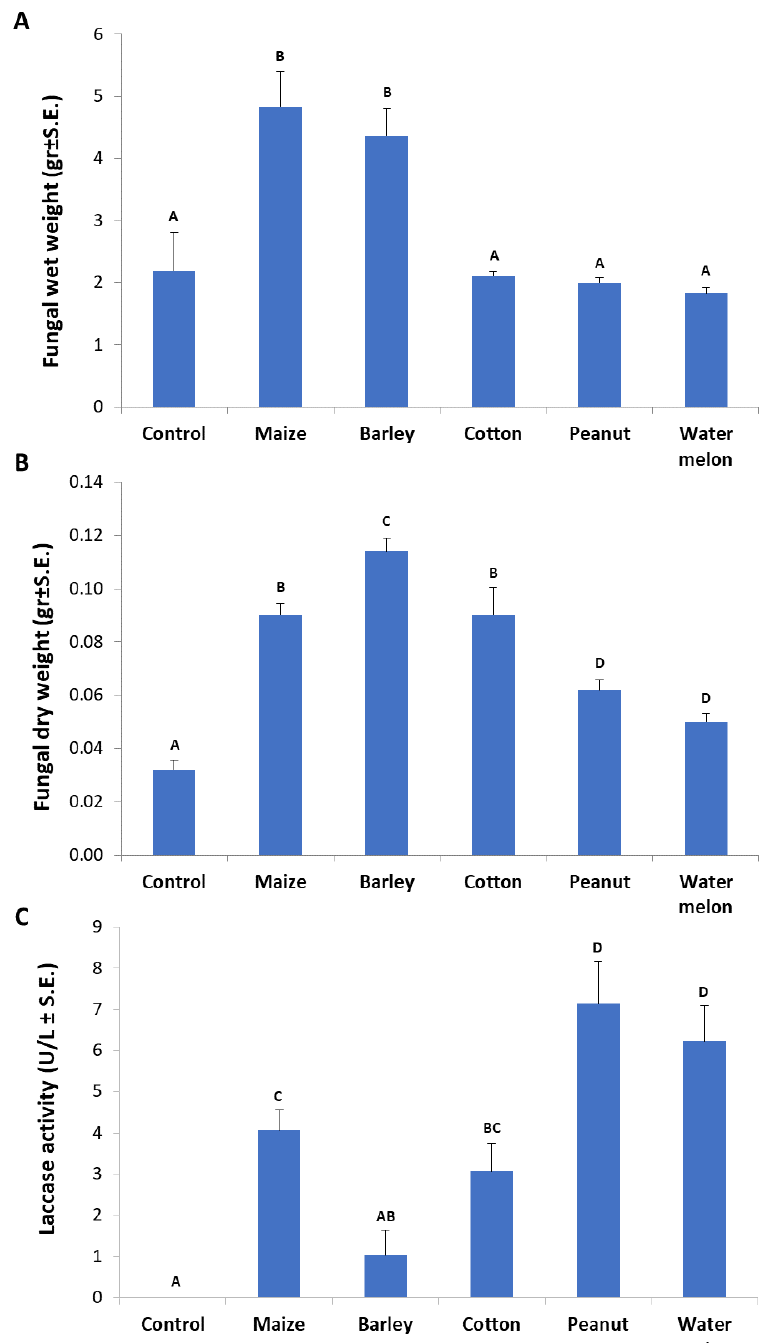
Figure 6. Influence of various plant species root powder on M. maydis growth in liquid minimal medium: The fungus was grown for seven days in 50 mL of a minimal medium with 0.1% glucose and 750 mg of ground plant parts from 40-day-old Prelude cv. maize plants and other plant species. ( A ) Fungal wet weight. ( B ) Fungal dry weight. ( C ) Laccase assay (performed as described in Figure 1). The enzymatic units (U) were defined as the amount of enzyme oxidizing 1 µmol ABTS in 1 min at 28 ± 1 °C in the dark. Bars indicate the mean of five replications. Levels not connected by the same letter (A, B, C, and D) are significantly different ( p < 0.05, ANOVA).